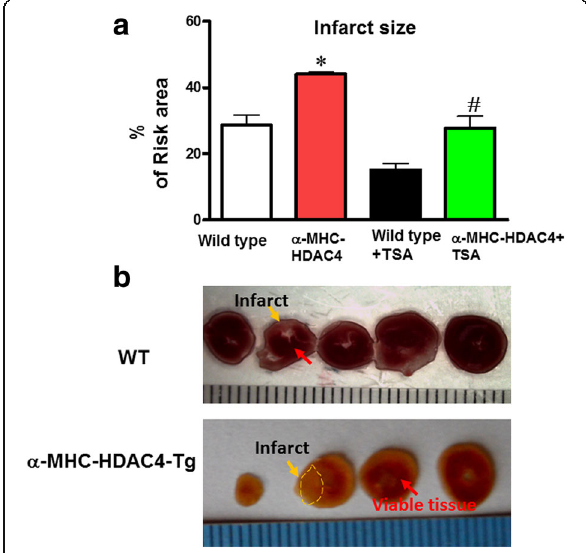
Fig. 4 Myocardial infarct sizes in wild type and α -MHC-HDAC4 mice in response to I/R injury. a Myocardial infarction in wild type littermates and α -MHC-HDAC4 mice. b Representative image of infarct size. At the end of the experimental protocol as described in Methods, the hearts were sliced into 4 – 5 sections and stained with 2,3,5-triphenyltetrazolium chloride followed by fixation in formalin. Viable areas are stained brick red, whereas infarcted areas are gray or white. Values represent mean± SE ( n =5/per group). * p <0.05 vs wild-type mice # p <0.05 vs wild-type mice + TSA and α -MHC-HDAC4